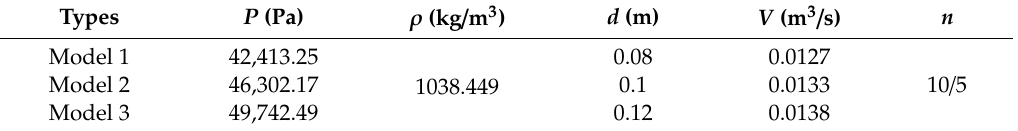
Table 3. Determination of the parameters of the enlarged model of a cerium chloride pyrolysis reactor.